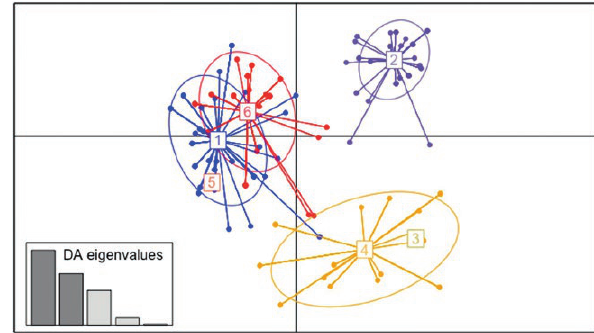
Figure 2. PCoA plot separating Punica genotypes in four main genetic groups.